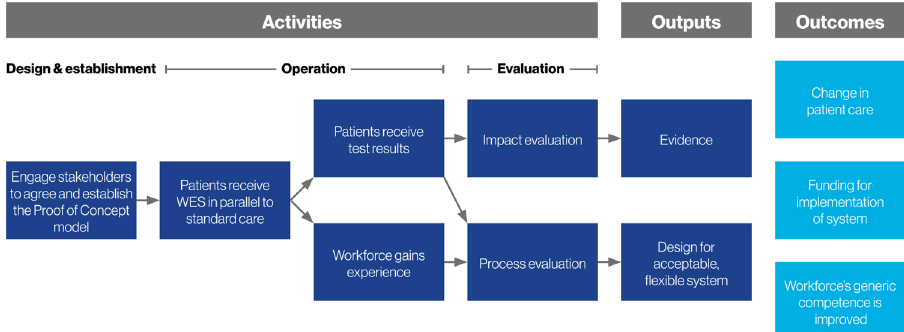
Fig. 1 Demonstration programme logic. This diagram summarises the programme logic model, that is the relationship between the demonstration project ’ s activities, its outputs and the intended